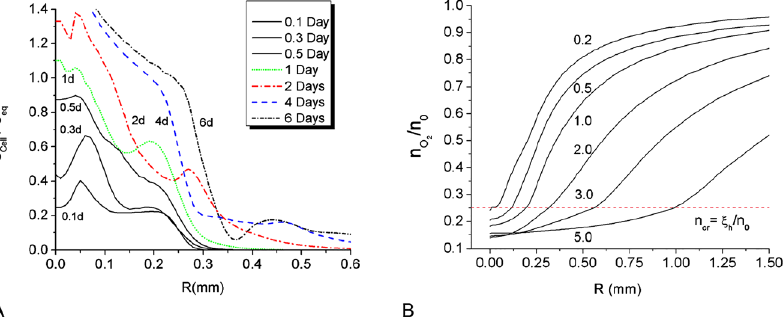
Figure 2: (A) Distributions of total cell densities for t = 0.2 – 5.0 days; (B) distribution of oxygen concentrations for t = 0.2 – 5.0 days; The line n cr = ξ h / n 0 shows hypoxic transition threshold level; n 0 is initial oxygen concentration, n 0 = 4